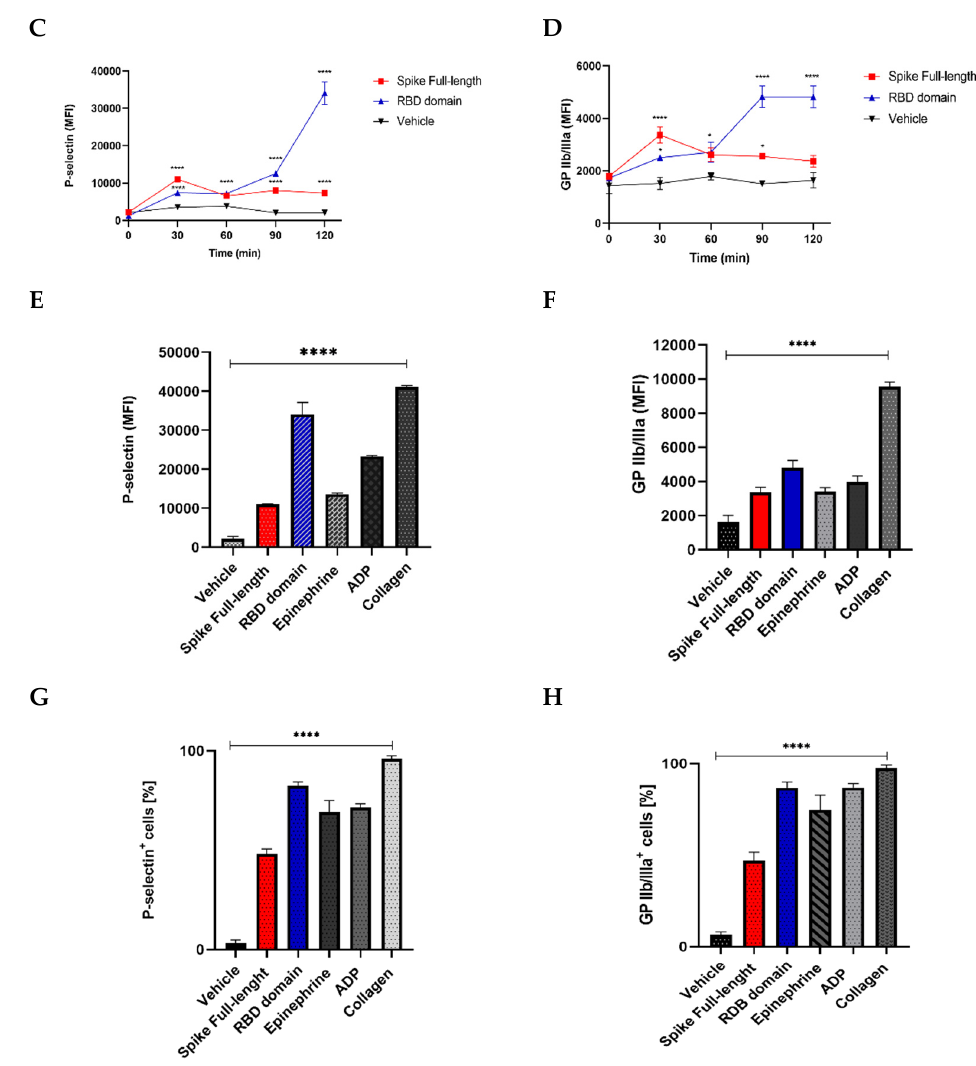
Figure 1. Platelet stimulation with full-length spike protein and RBD domain. Platelet-rich plasma was incubated for 60 min at 37 °C with spike full-length and RBD domain at different concentrations. Mean fluorescence expression of platelet activation markers when incubated with the spike full-length and RBD domain ( A , B ). Platelet-rich plasma was incubated for different times at 37 °C with spike full-length and RBD domain at a concentration of 2.0 ug/mL. Tyrode´s buffer was used as control ( C , D ). Mean Fluorescence Intensity expression of P-selectin and GP IIbIIIa, respectively, on platelets´ surface when incubated with spike full-length protein, RBD domain, and Tyrode´s buffer at different times ( E , F ). Comparison between maximal expression of activation markers P-selectin (CD62) and GP IIbIIIa (PAC1). Spike full-length protein for 30 minutes (2.0 ug/mL), RBD domain 120 minutes 2.0 ug/mL, Tyrode’s buffer as vehicle and ADP 20 uM (20 min), epinephrine 100 uM (40 min) and collagen 20 uM (30 min) as known activation agonists ( G , H ). Comparison of maximum expression of activation markers indicating the percentages of P-selectin ( G )- and GP IIbIIIa (H)-positive cells after stimulation with viral proteins spike full-length and RBD domain, known activation agonists and vehicle. p values were calculated using one-way ANOVA and Tukey´s post-hoc tests ( n = 3). Data presented as Mean ± SD. * p < 0.05, ****: Statistical difference p < 0.0001.